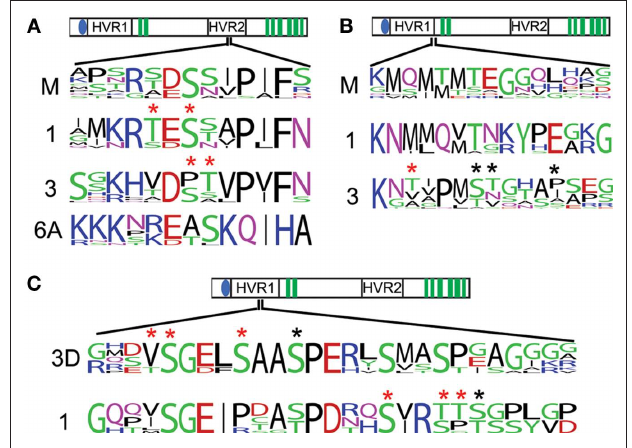
FiGuRe 4 | Conserved phosphorylation sites of interest. The conservation of observed phosphorylation sites is detailed by frequency plots. Red asterisks are placed above positions in which phosphorylated peptides were observed, but the specific residue phosphorylated was ambiguous. Black asterisks are place above unambiguous phosphorylation. A region near the catalytic sites has strongly conserved serines/threonines in the primary CesAs and the moss and lycophyte sequences (A) . Serines/threonines observed to be phosphorylated in CesA3 are strongly conserved and aligned to a strongly conserved serine/threonine in CesA1 and the moss and lycophyte sequences (B) . A phosphorylated region shows strong conservation within the CesA1 family is also found to have several phosphorylated serines/threonines in the CesA3 family, but only in eudicots (labeled 3D), possibly indicating phosphorylation here is a recent adaptation in eudicot CesA3s (C) .